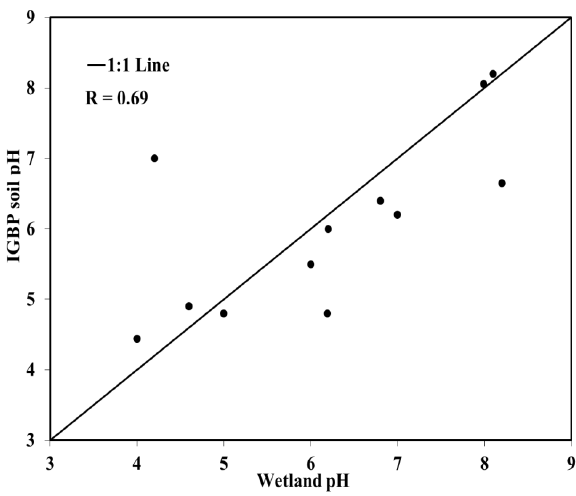
Fig. A. Comparison between wetland pH and IGBP soil pH. 2" Fig. A1. Comparison between wetland pH and IGBP soil